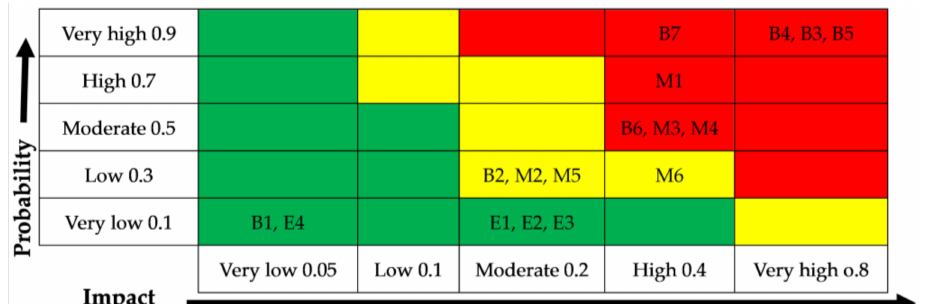
Figure 8. The risk matrix diagram. Note: The figure is mapped based on Table